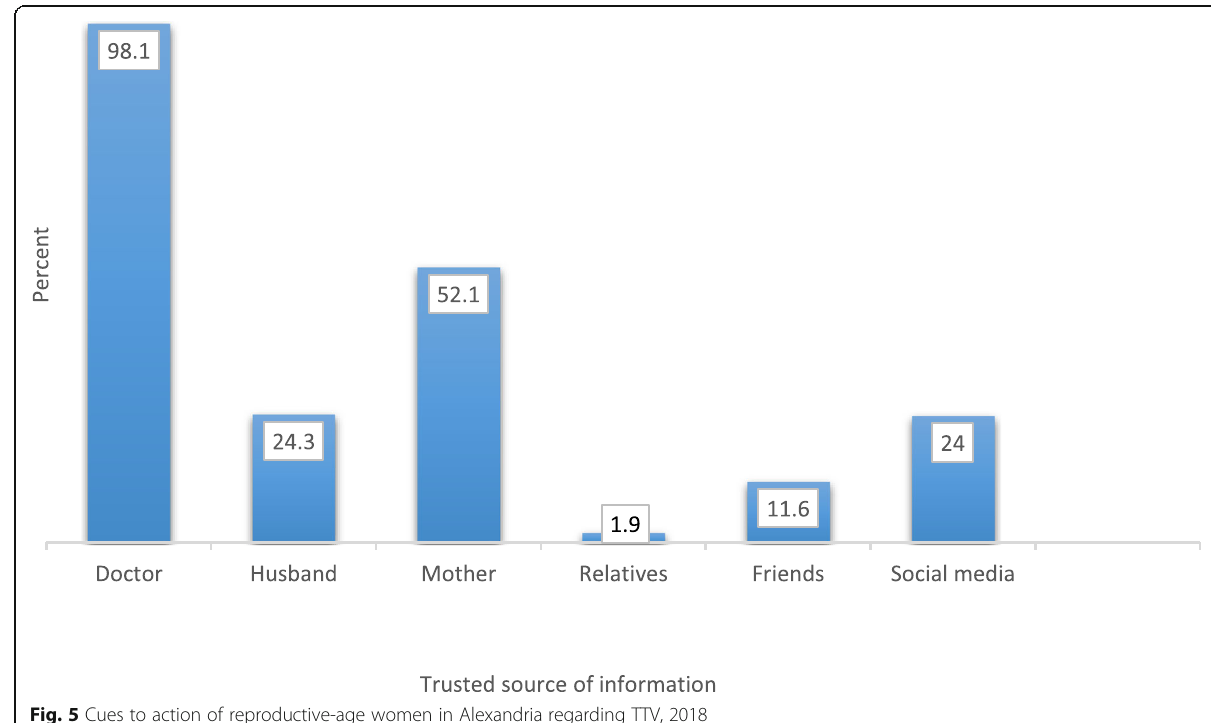
Fig. 5 Cues to action of reproductive-age women in Alexandria regarding TTV, 2018